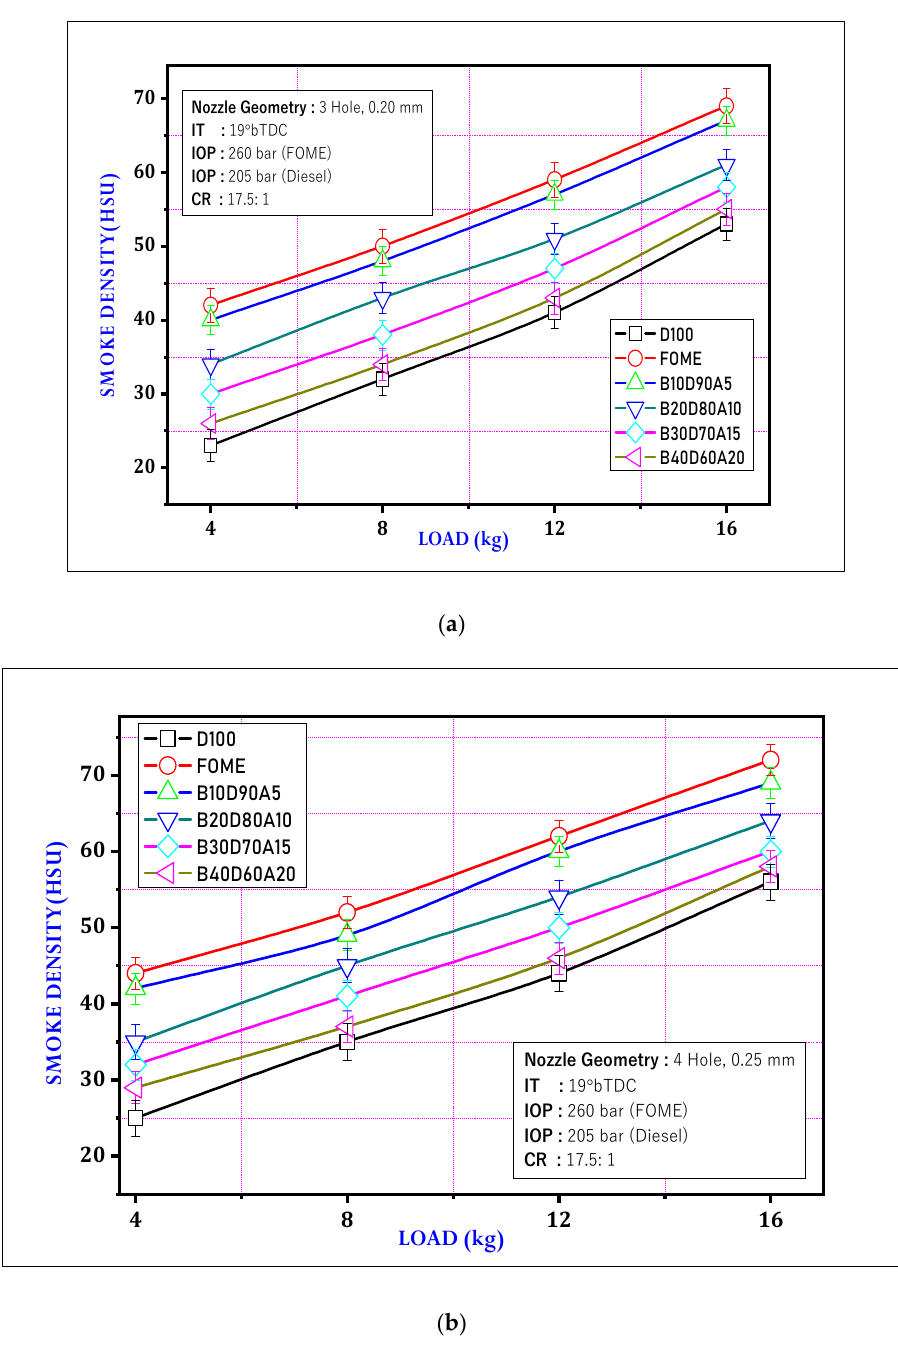
Figure 12. ( a ) Variation in smoke emission with load for 3-hole fuel injector. ( b ) Variation in smoke emission with load for 4-hole fuel injector.